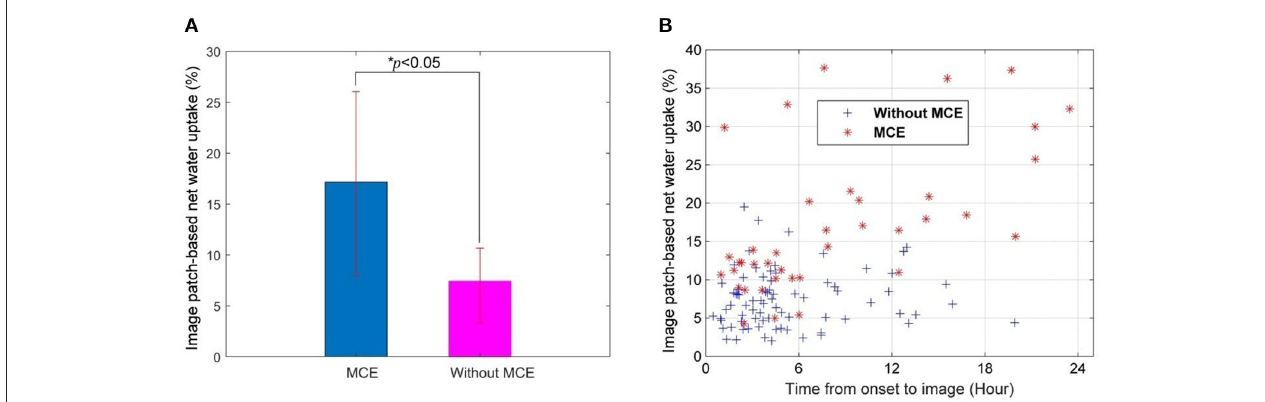
FIGURE 3 | Image patch-based net water uptake (IP-NWU) and its relationship with time. (A) IP-NWU comparison between patients with MCE and without MCE; (B) The relationship between IP-NWU and time from stroke onset to imaging.